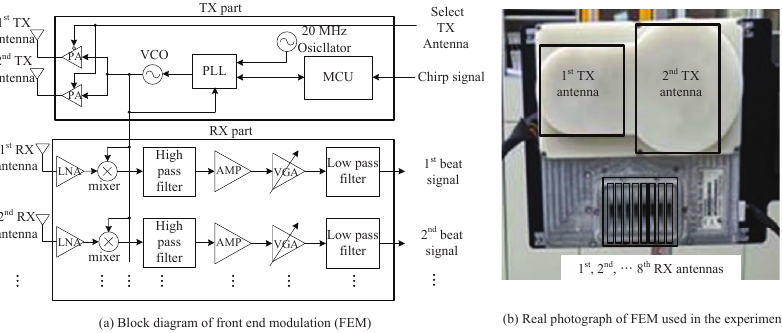
Figure 12. Block diagram of front-end module (FEM) and its real